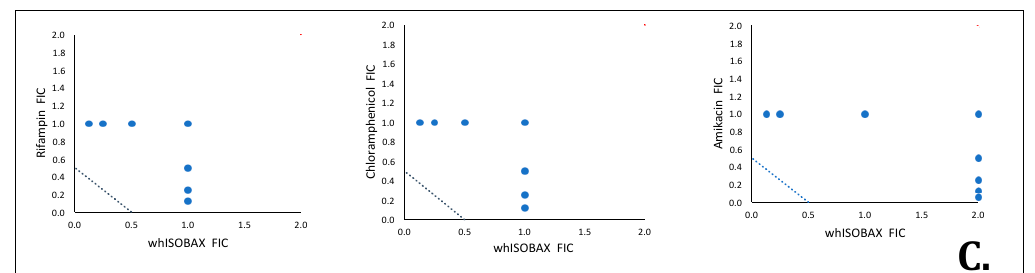
Figure 2. ( A ) Checkerboard assay of WH and linezolid against S. aureus ; bacteria were grown in 96-well plates with increasing amounts of WH and / or antibiotic overnight at 37 ◦ C, and cell density was determined. Wells in which there was visible bacterial growth are presented as green, while wells with no bacterial growth are presented as red. WH concentrations are expressed as a final dilution of initial extract (1 / 240 to 1 / 61,440). Antibiotic concentrations are expressed as mg / L (0–4 mg / L). ( B , C ) Isobologram analysis of Checkerboard assay of cells grown with increasing concentrations of WH and antibiotics. Panel B shows the e ff ect on S. aureus ATCC 29213 while panel C showed the e ff ect on E. coli ATCC 25922. Fractional Inhibitory Concentrations (FICs) of WH are reported on the x -axis and FICs of antibiotics are reported on the y -axis. Dotted line represented limits for considering a combination as synergistic (0.5). FIC Index (FICI) values are indicated and are colored as green if synergistic (FICI ≤ 0.5).